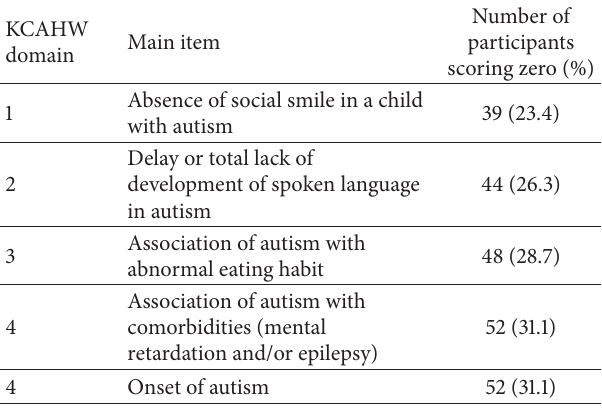
Table 3: Items associated with major knowledge gaps in